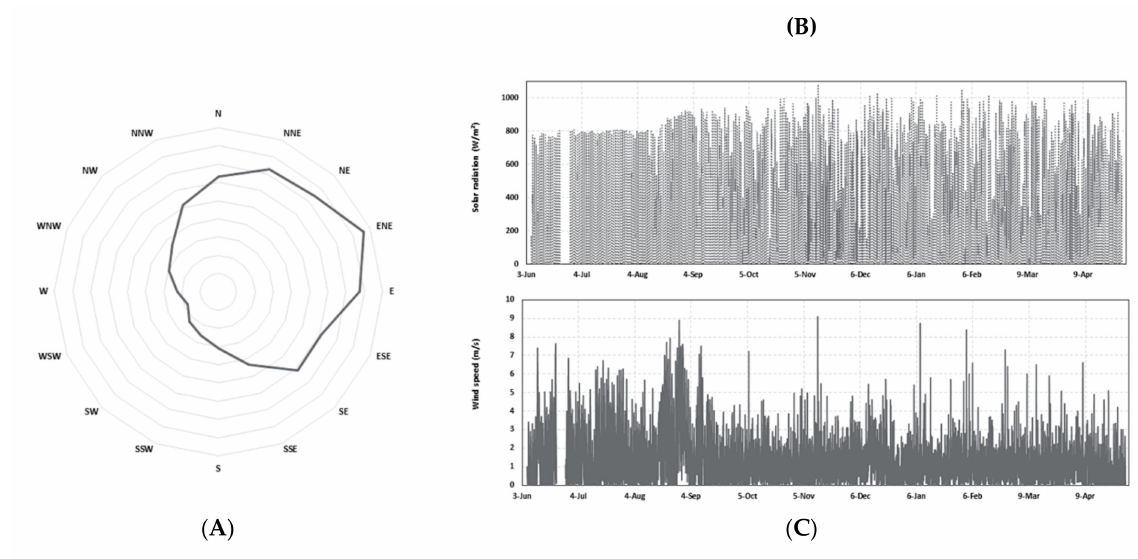
Figure 10. Outdoor climate: ( A ) Wind direction; ( B ) Solar Radiation; ( C ) Wind